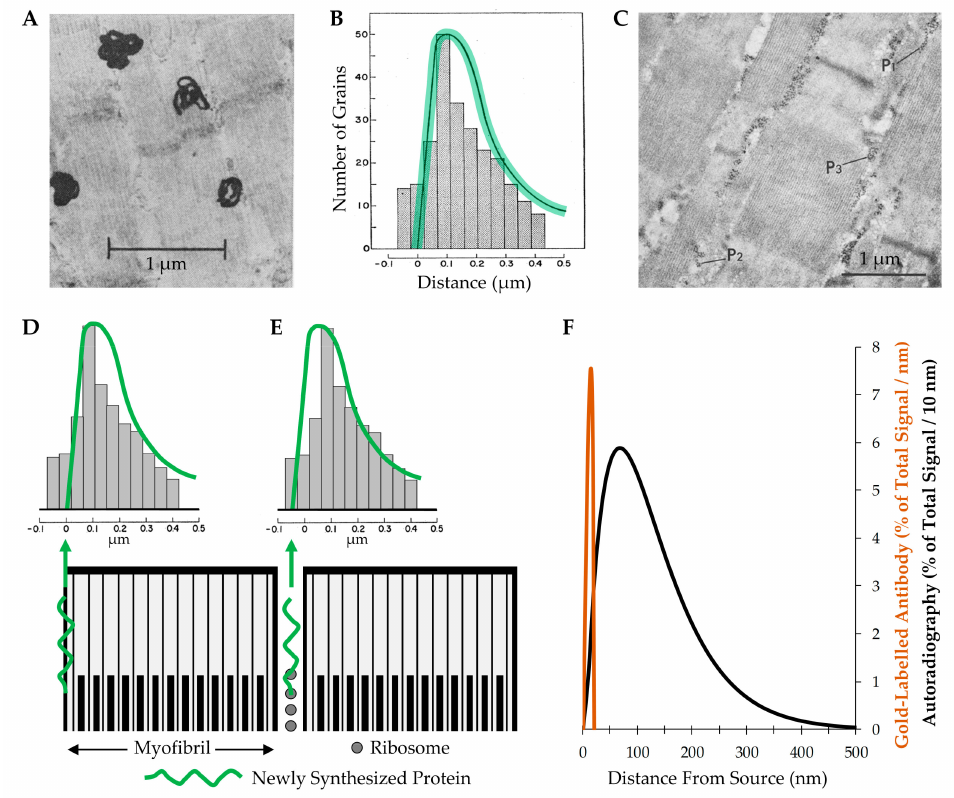
Figure 10. ( A ) Electron microscope autoradiograph from Morkin (1970) which shows the large electron dense grains that were used to identify the location of newly synthesized proteins in the rat